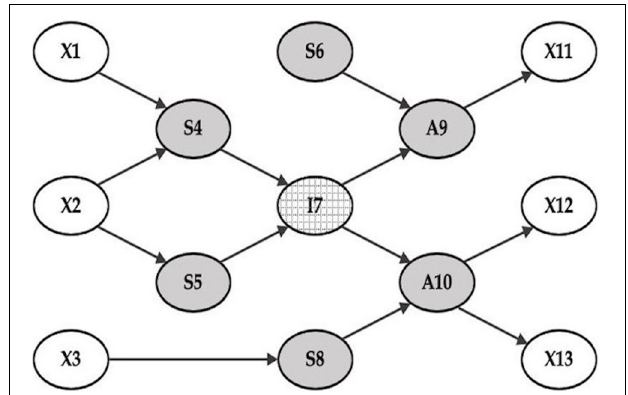
FIGURE 1 | A Markov blanket. A Markov blanket of a particular node probabilistically defines the state of a particular node without being affected by the state of any other nodes. The external states are outside the Markov blanket (the nodes of X1, X2, X3, X11, X12, X13), which are the environment or the world (and body) in which we live. The internal state, or I7, is what is inside—the neuronal and possibly conscious self. The Markov blanket consists of the gray circles surrounding the internal state I7. Among them, the nodes A9 and A10 are active states influenced by the internal state and influencing the environment, or the external states (X11, X12, and X13). The rest are the sensory states, and there are two types: one that provides the sensory data to the internal state (S4 and S5), such as sensory organs producing perceptions; the other directly influences the active states without going through the internal state (S6 and S8), such as automated sensory-motor reflexes processing information at a sub-personal level, unconsciously. The human body, comprising sensory states (S4, S5, S6, and S7) and active states (A9 and A10), lies between the internal state (i.e., sentience) and the external states (i.e., environment). Note that the arrows in this graphical model represent Markovian dependencies, referring to probabilistic effects, rather than strictly deterministic